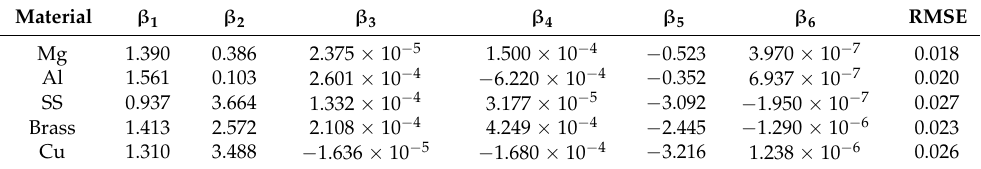
Table 3. R_value calibration surface coefficients.